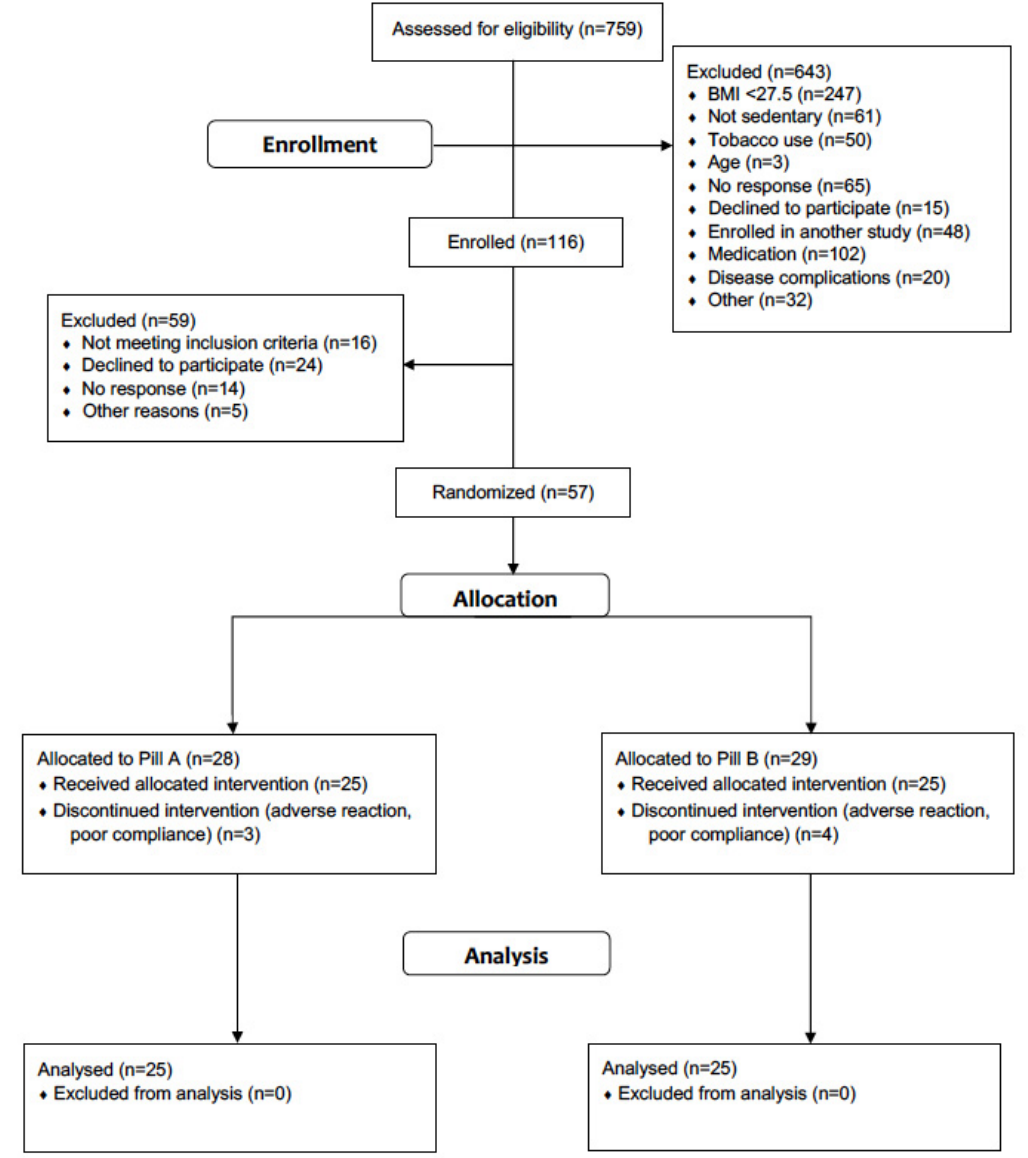
Figure 1. Progress of all participants throughout the trial (from screening through to